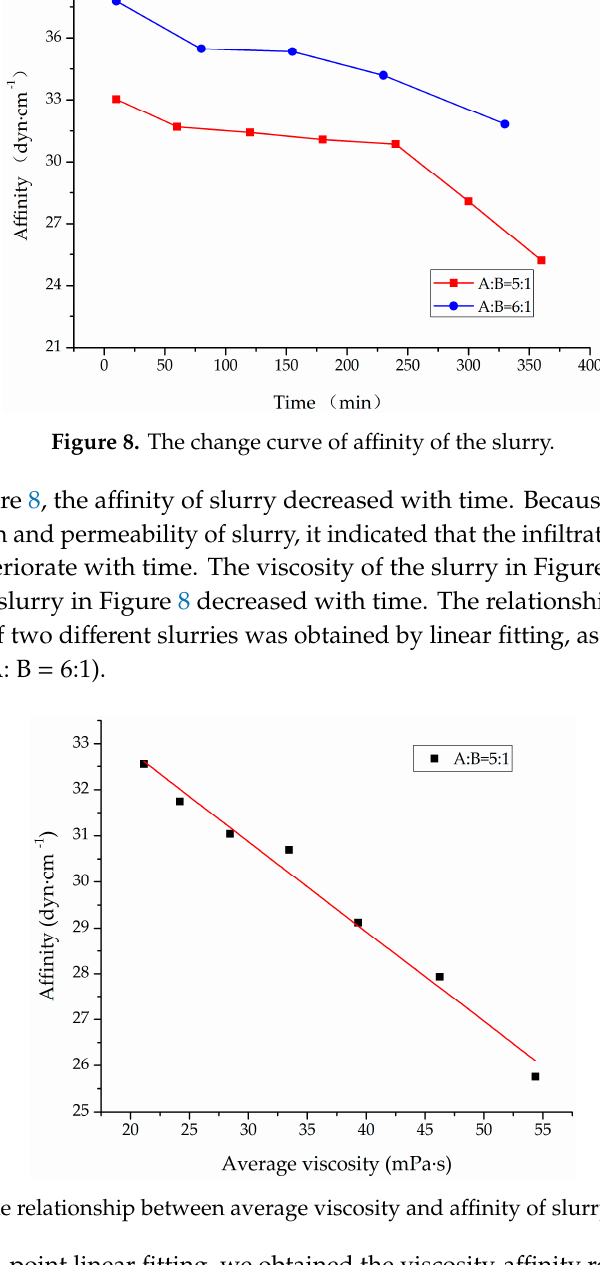
Figure 10. The relationship between average viscosity and affinity of slurry (A:B = 6:1). By substituting Equation (5) into Equation (11) and introducing integral algorithm, the affinity-time mathematical model of slurry with mass ratio A:B = 5:1 could be obtained: